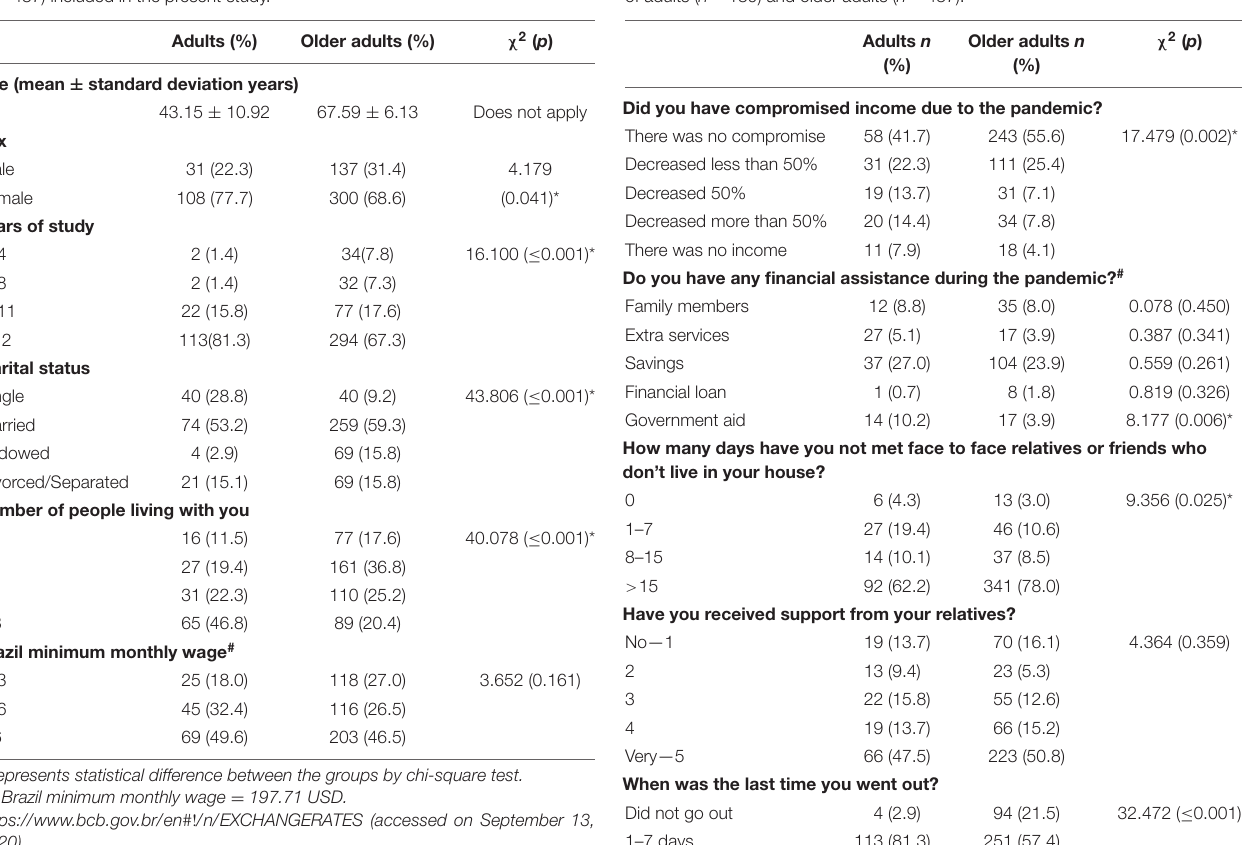
TABLE 1 | Sociodemographic characteristics of adults ( n = 139) and older adults ( n = 437) included in the present study.